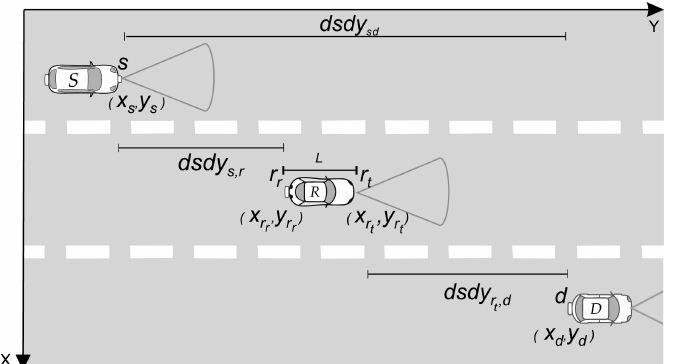
Figure 1. Schematic of a V2V-VLC cooperative network with an intermediate relay vehicle.